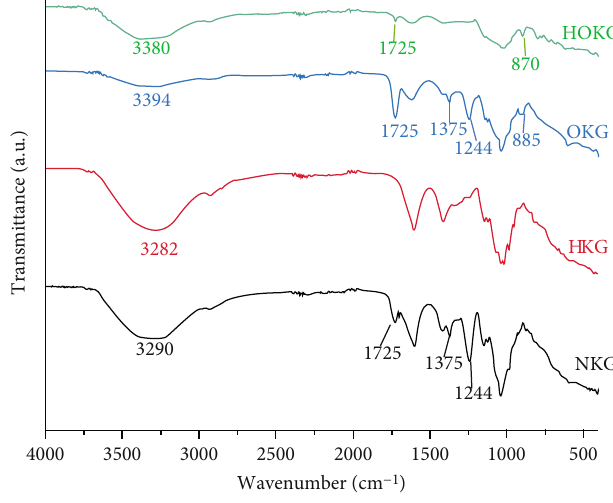
Figure 3: FTIR spectra of KG samples.